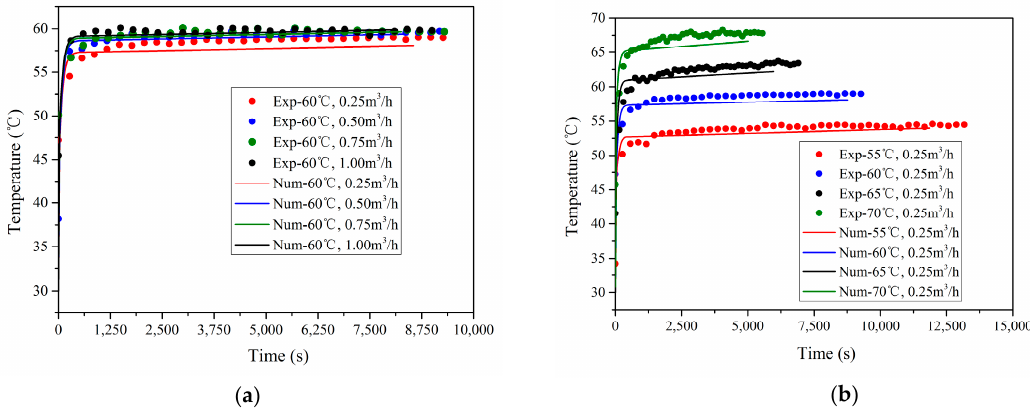
Figure 12. Experimental and numerical outlet temperature profiles over time for Case 1–7. ( a ) Case 1, Case 2, Case 3 and Case 4; ( b ) Case 1, Case 5, Case 6 and Case